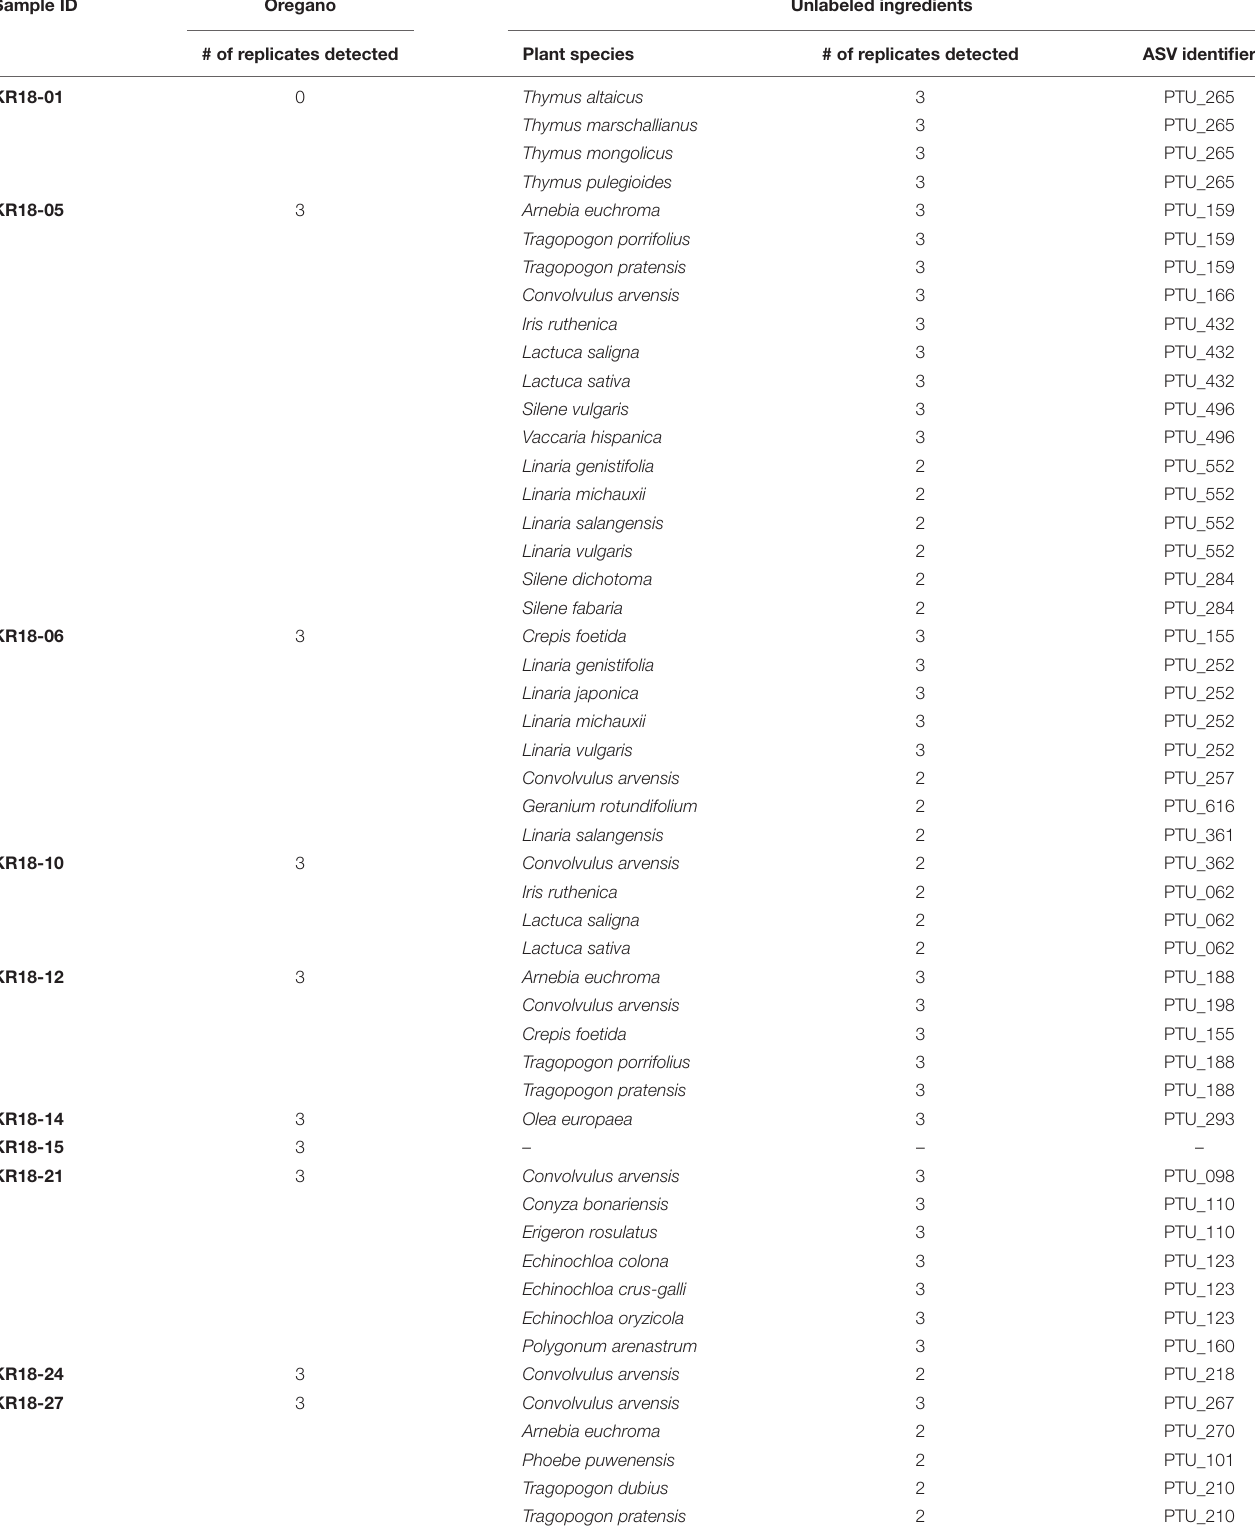
TABLE 2 | DNA metabarcoding based authentication of the products labeled as containing oregano. Sample